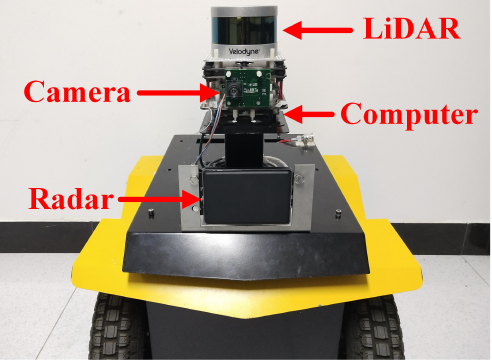
Figure 8. The wheeled robot used in our experiments, equipped with a LiDAR, a mmW-radar, a camera and a